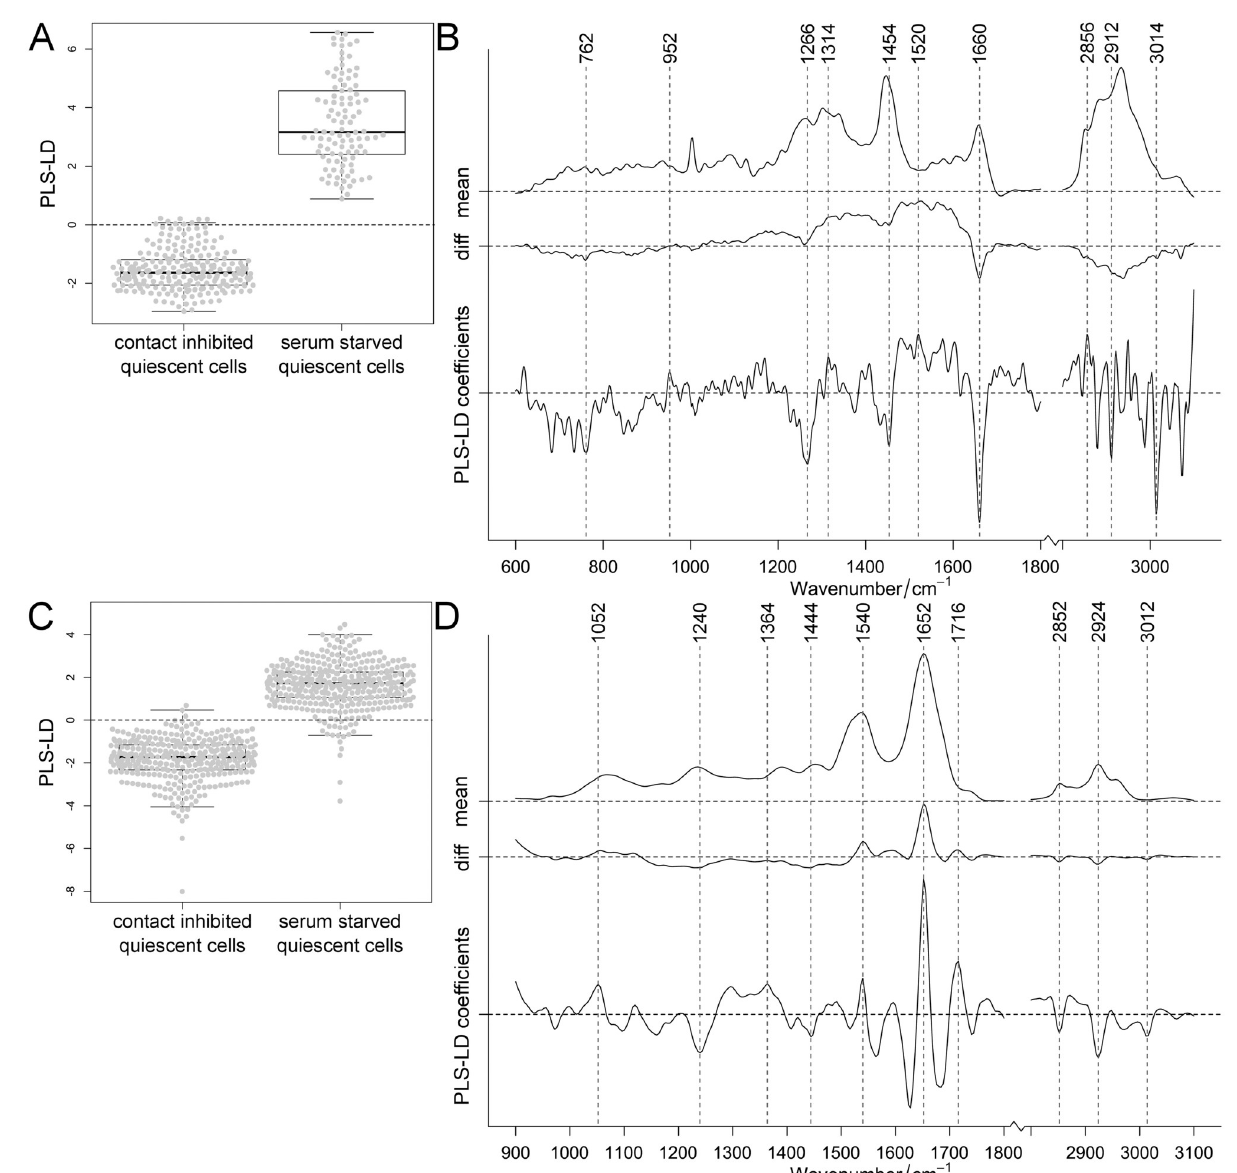
Fig 3. Classification of contact-inhibited and serum-starved quiescent cells. PLS-LDA of Raman (A, B) and FT-IR spectra (C, D) of cells in which quiescence was induced either by contact inhibition or by serum starvation (data sets for 14 and 100 days induction combined). Distribution of cells shown in one-dimensional scatter plots combined with box-plots (A, C) showing 95% confidence interval with p-values < 0.001 for Raman and FT-IR data. Mean and difference spectra (“diff”, serum starvation vs. contact inhibition) from the classified cells are plotted together with the PLS-LD coefficients vs. the wavenumber (B,